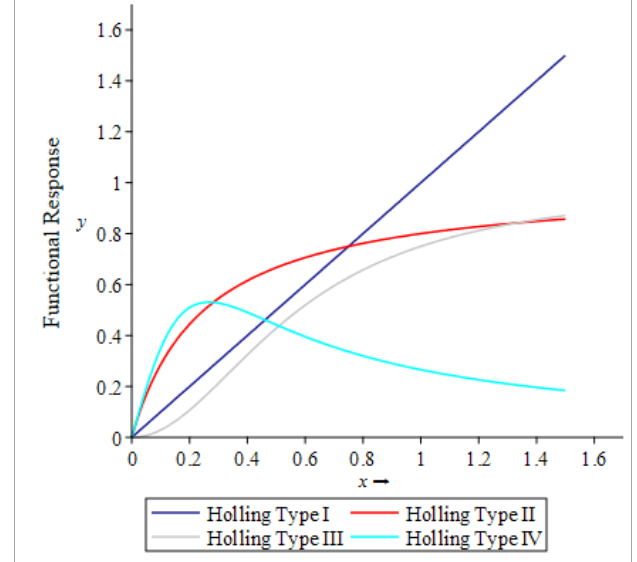
Figure 1. Trajectories Holling response